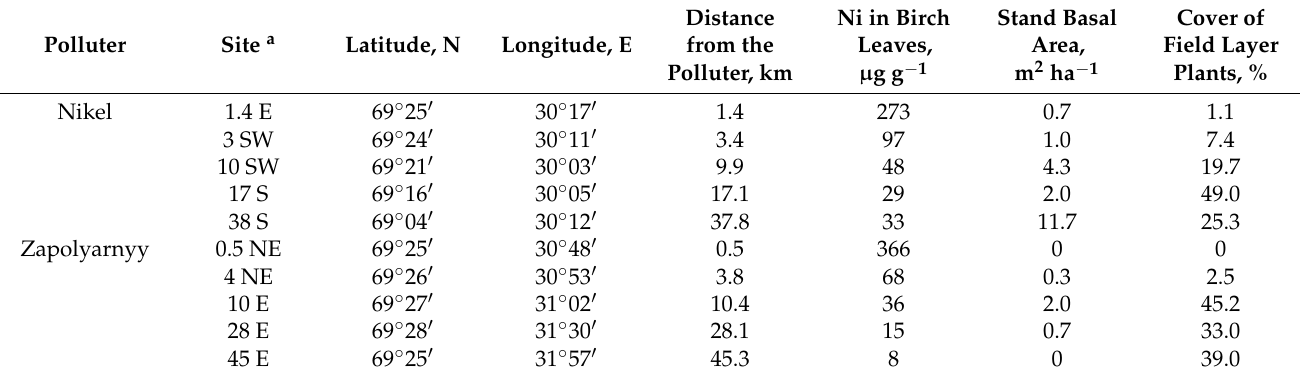
Table 2. Characteristics of study sites (after